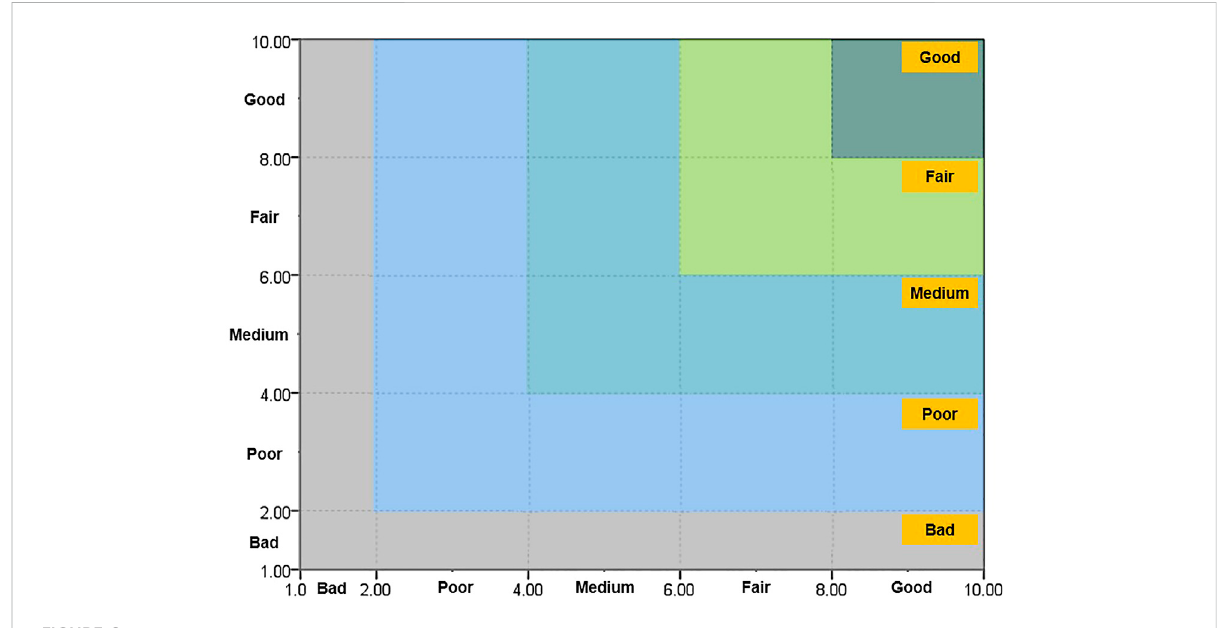
FIGURE 6 Barometer of Sustainability proposed by Prescott-Allen (2001), applied for the SSI.